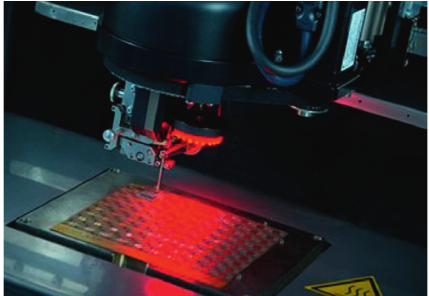
Figure 3: Wire bonding.